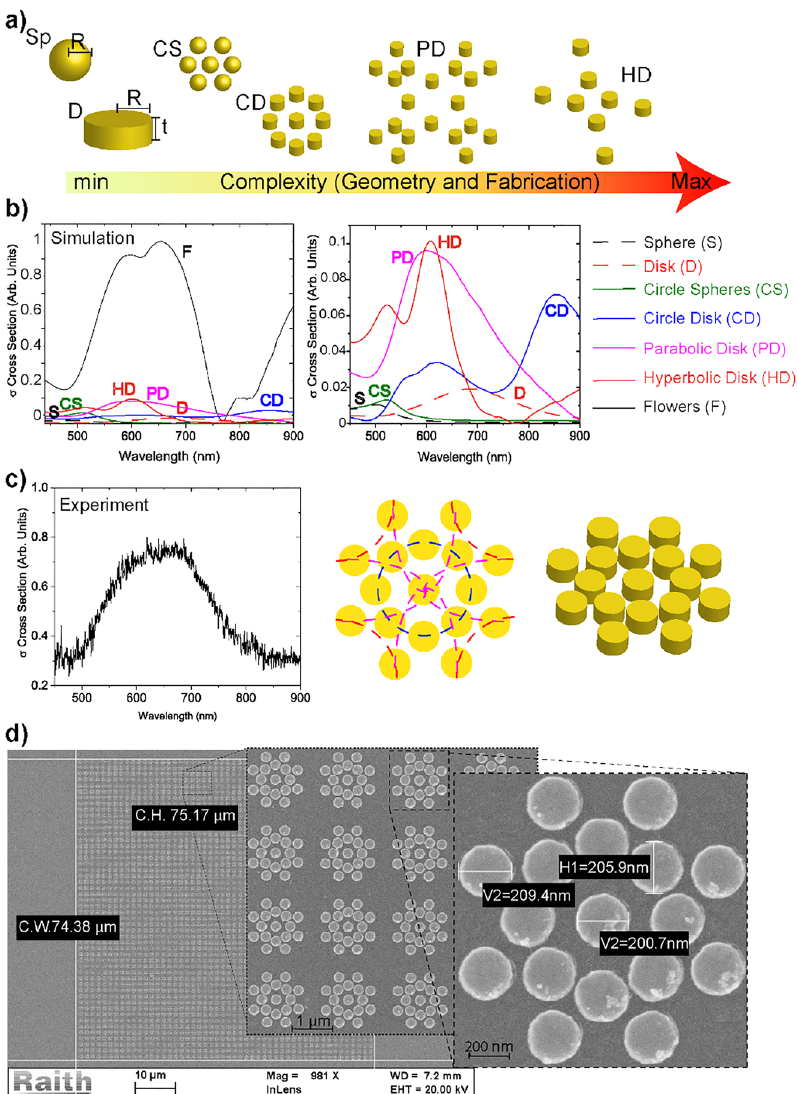
Figure 1: (a) Schematic view of different nanostructures arrangement where Sp and D refer to sphere and disk, respectively; C, P and H refer to circle, parabolas and hyperbo- las,respectively.(b)Absorptioncrosssection of the consider nanoparticles arrangement, namelysinglesphere(dottedblackline),sin- gle disk (red), circle spheres (green), circle disk (blue), parabolic disk (pink), and hyper- bolic disk (reddish) and flower (black). The right frame shows the same curves of the left butrescaledtobetterevidencetheplasmonic features of the considered arrangements. (c) Experimental absorption cross section as a function of the wavelength for the fabri- cated nano flowers, the arrangement of a single flower is reported in the schematic view on the right side. (d) Scanning elec- tron microscope (SEM) micro-graphs of the fabricated plasmonic nano heater in flower